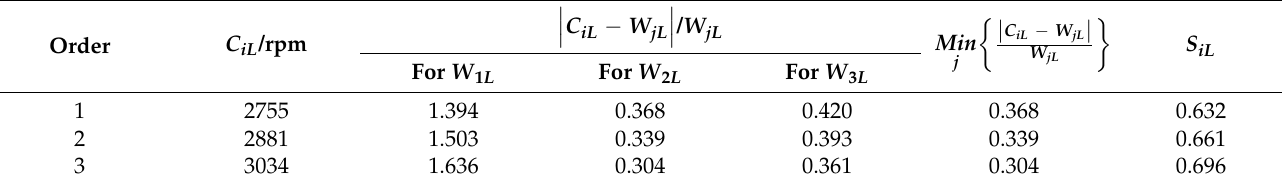
Table 4. Critical speed risk coefficients of the low-pressure rotor.